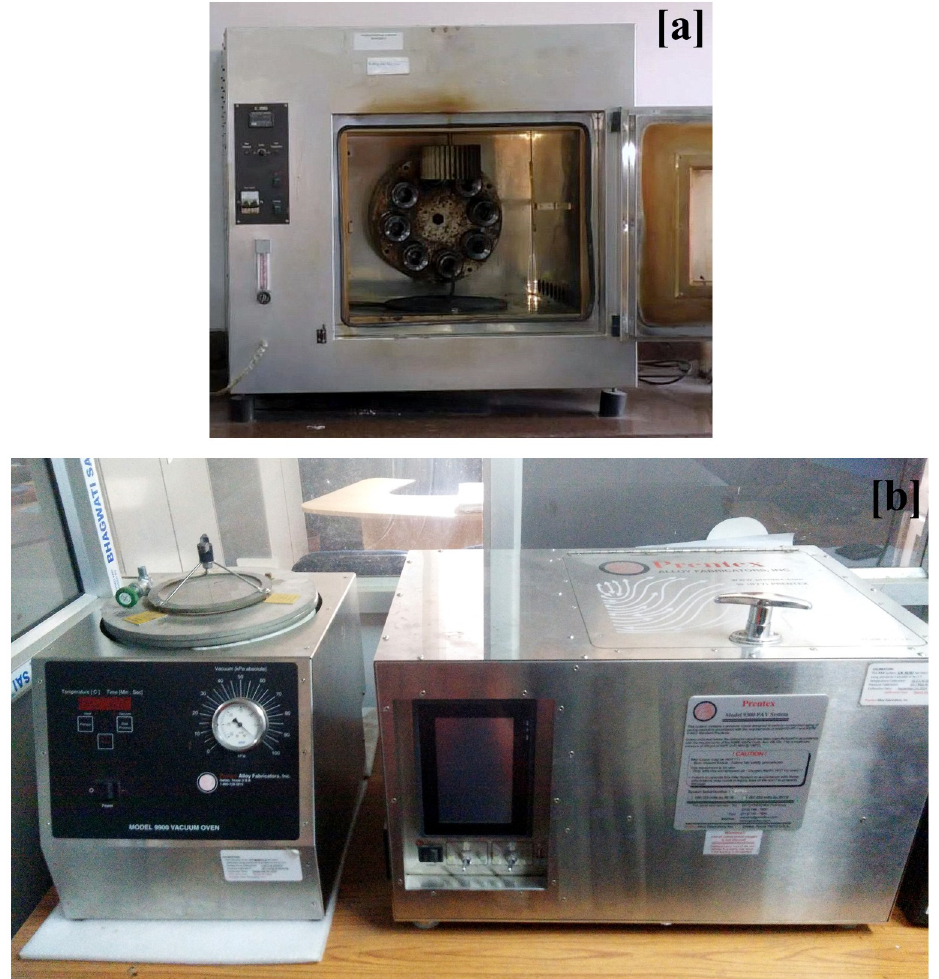
Fig 3. (a) RTFO device used for simulation of short-term aging, and (b) PAV device used for simulation of long- term